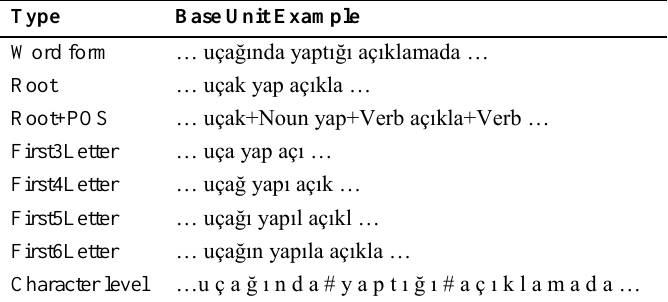
Table 2. Base unit examples for language